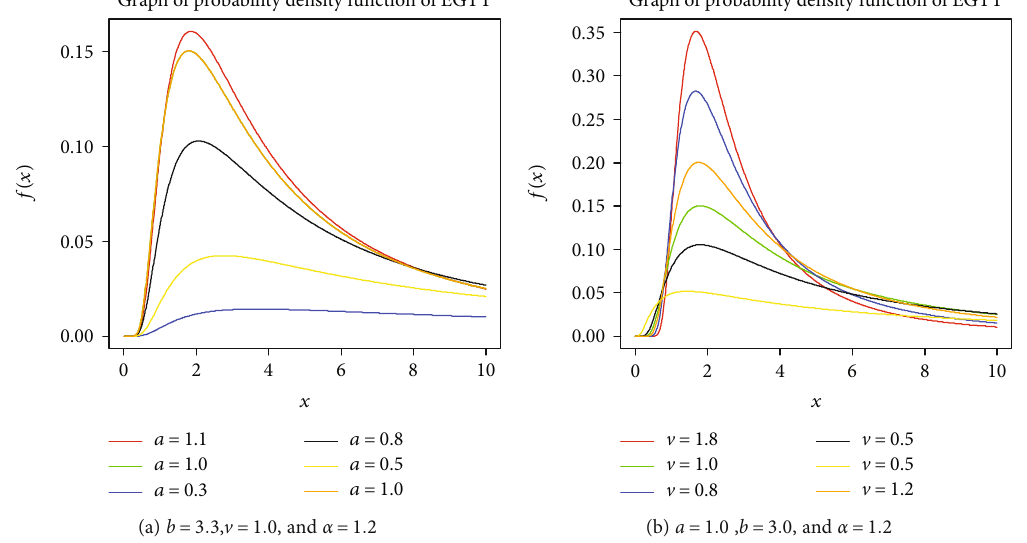
Figure 2: The graphs of the pdf of EGTT